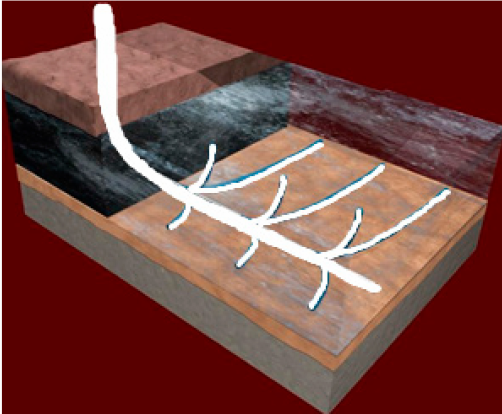
Figure 1. Multilateral horizontal drilling is characterized by small-diameter branches stemming from the main horizontal well tree trunk, thus significantly increasing the peripheral oil well output. In multilateral horizontal drilling applications the navigation requirements become even more stringent compared to traditional MWD-based horizontal directional drilling. Traditional MWD HDD surveying tools determine the roll and the pitch of the drill bit by employing three-axe accelerometers and the azimuth of drill bit using three-axe magnetometers [7]. However, the precision of the magnetic surveying sensors is corrupted by several factors: (1) magnetometers are susceptible to external interferences caused by currents flowing in the atmosphere and solar winds, which can introduce independent errors distorting the calculation of the MWD toolset orientation [8]; (2) the presence of drilling fluids and debris downhole interacts with the earth magnetic field and further increases the azimuth error by up to 5° [9]; and (3) ferromagnetic interferences from the drill especially significant when the well is drilled in the east/west direction [10,11]. In addition,